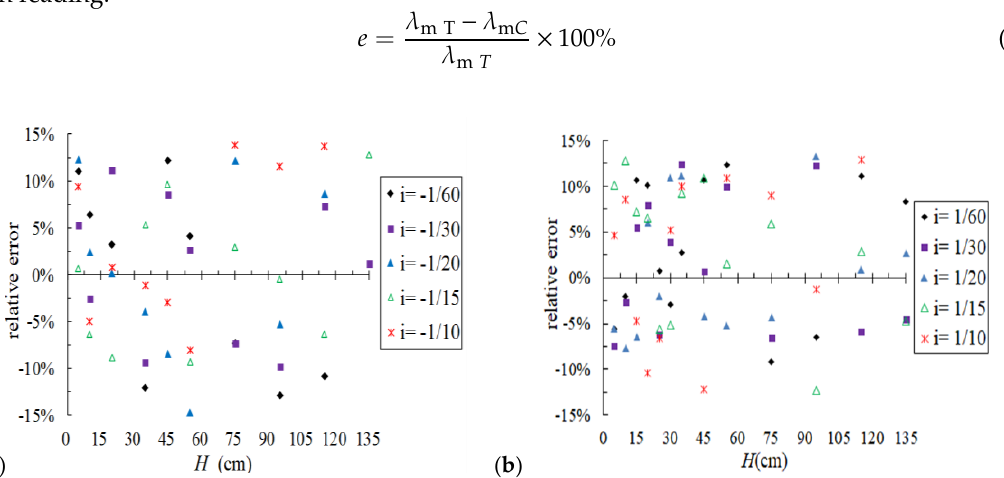
Figure 13. Relative error between the test value and the calculated value of the resistance coefficient: ( a ) pipes set on the reverse slope, ( b ) pipes set on the positive slope.